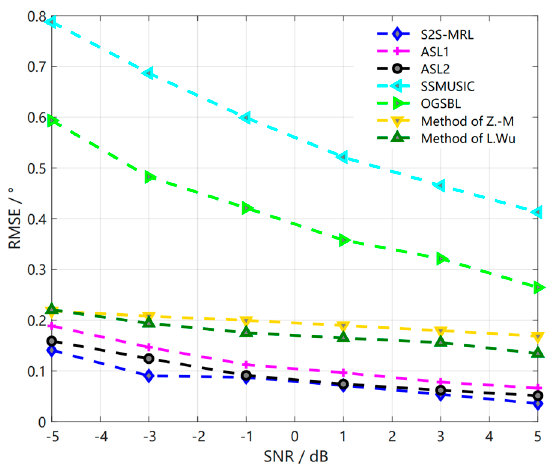
Figure 11. Comparison of RMSE of S2S network meta − reinforcement learning algorithm with other methods in the original environment.